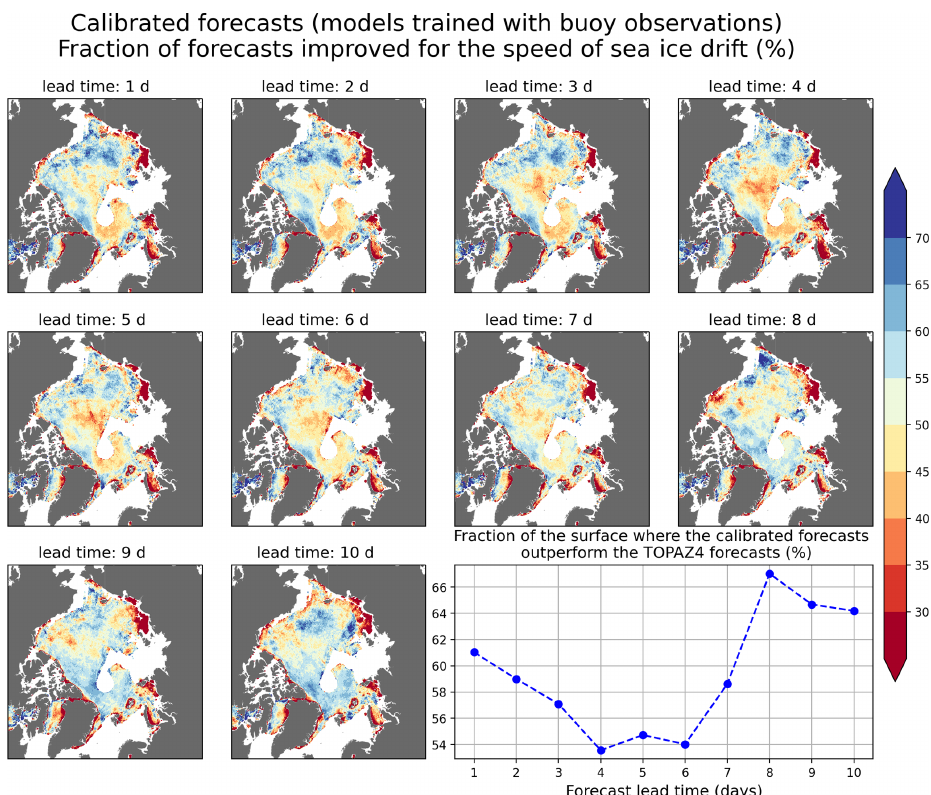
Figure 6. Fraction of calibrated forecasts produced by the models trained with buoy observations which outperform the TOPAZ4 forecasts for the speed of sea ice drift during the period from June 2020 to May 2021. Daily SAR observations have been used as reference. The graph in the lower right corner shows the fraction of the surface where the fraction of calibrated forecasts outperforming the TOPAZ4 forecasts is higher than or equal to